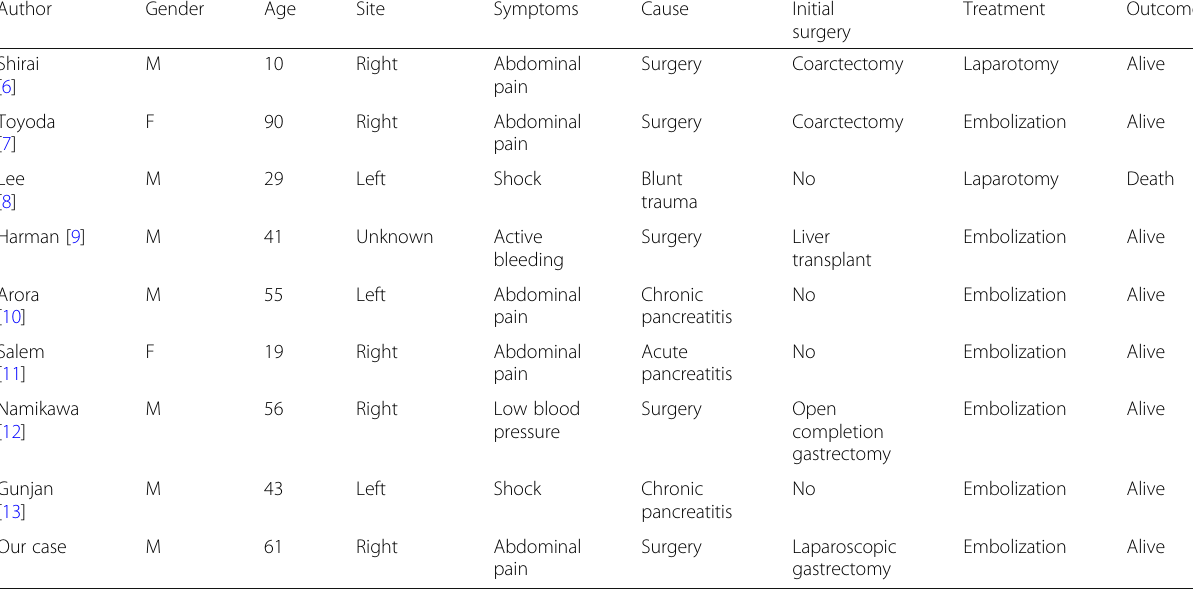
Table 1 Clinical characteristics of patients with a ruptured inferior phrenic artery